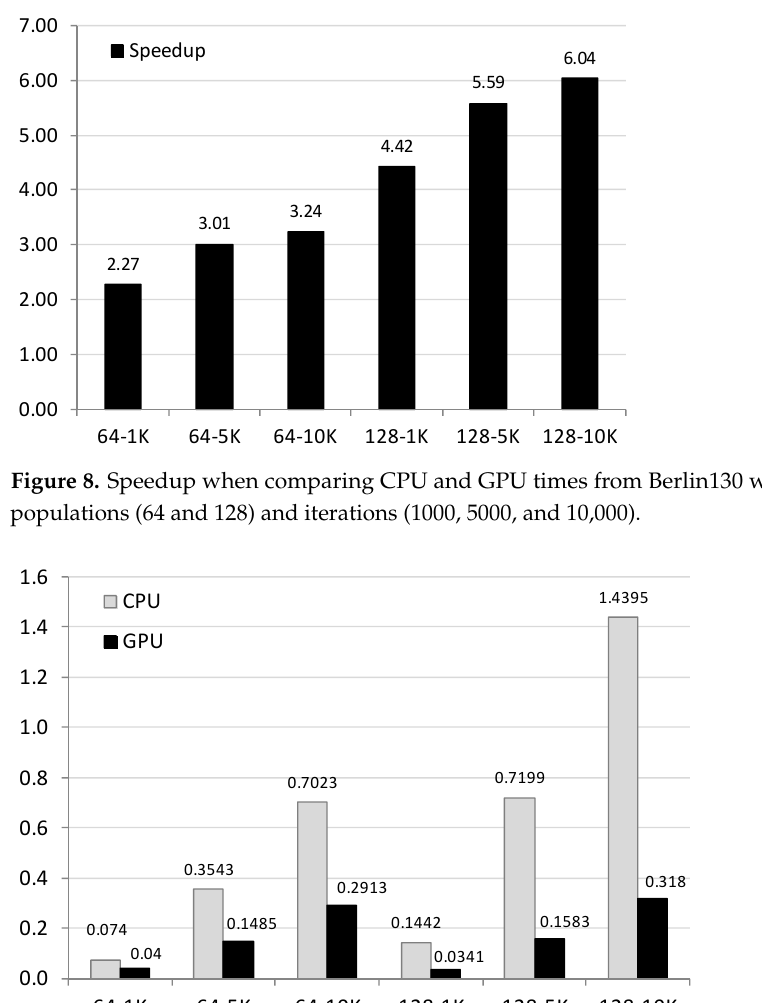
Figure 7. CPU and graphics processing unit (GPU) times (in ms) from Berlin130 with respect to different populations (64 and 128) and iterations (1000, 5000, and 10,000).